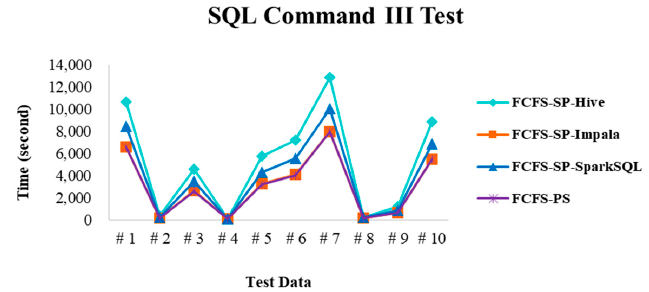
Figure 22. Execution time of SQL command III in test environment II.